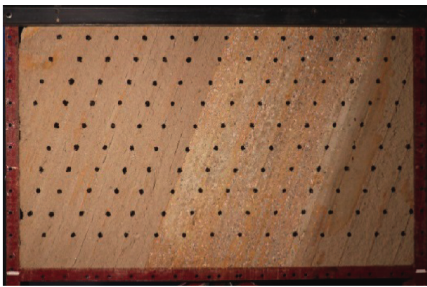
Figure 7: Sketch map of model